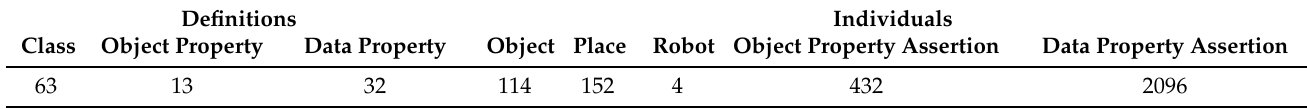
Figure 6. The explicit model-based visualization of the generated semantic map for the entire environment. Table 4. Metric information for the semantic